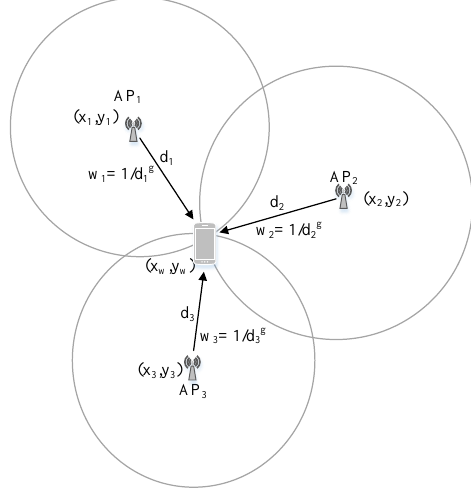
Figure 9. Procedure for estimating weighted centroid (WC) localization at a tag